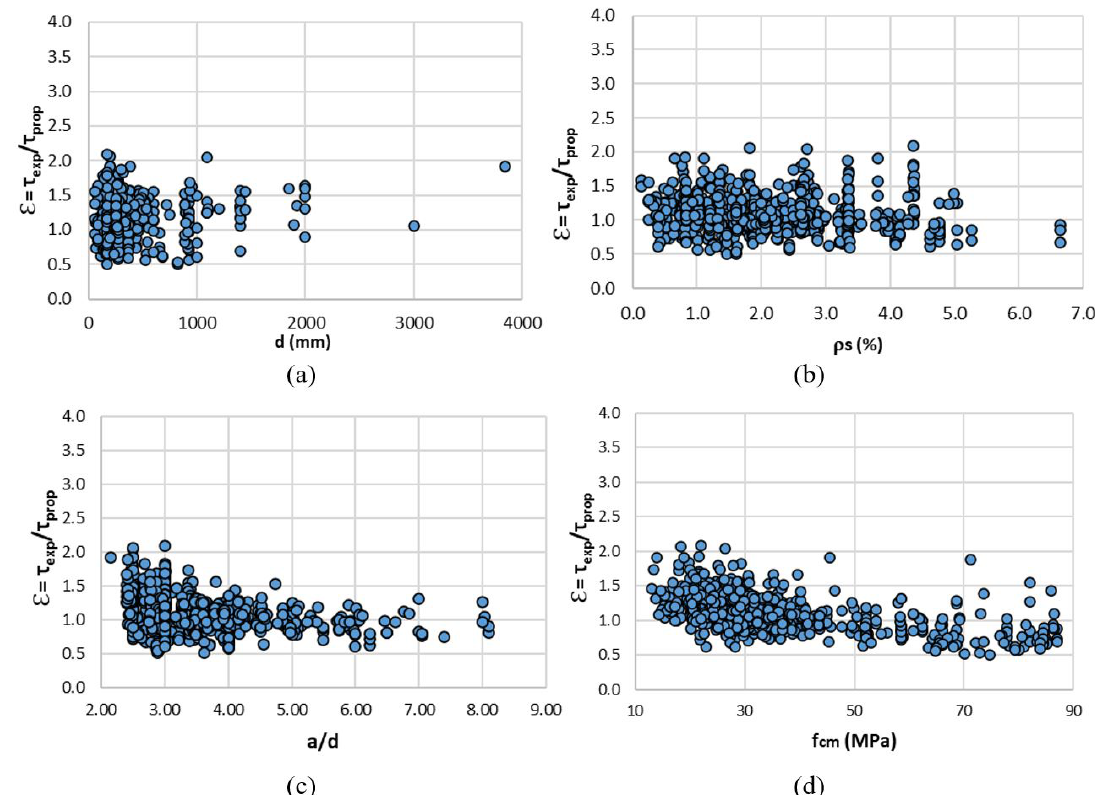
Figure 6. Impact of (a) effective depth, (b) longitudinal reinforcement rate, (c) a/d ratio and (d) average concrete strength on model error for the proposed equation.